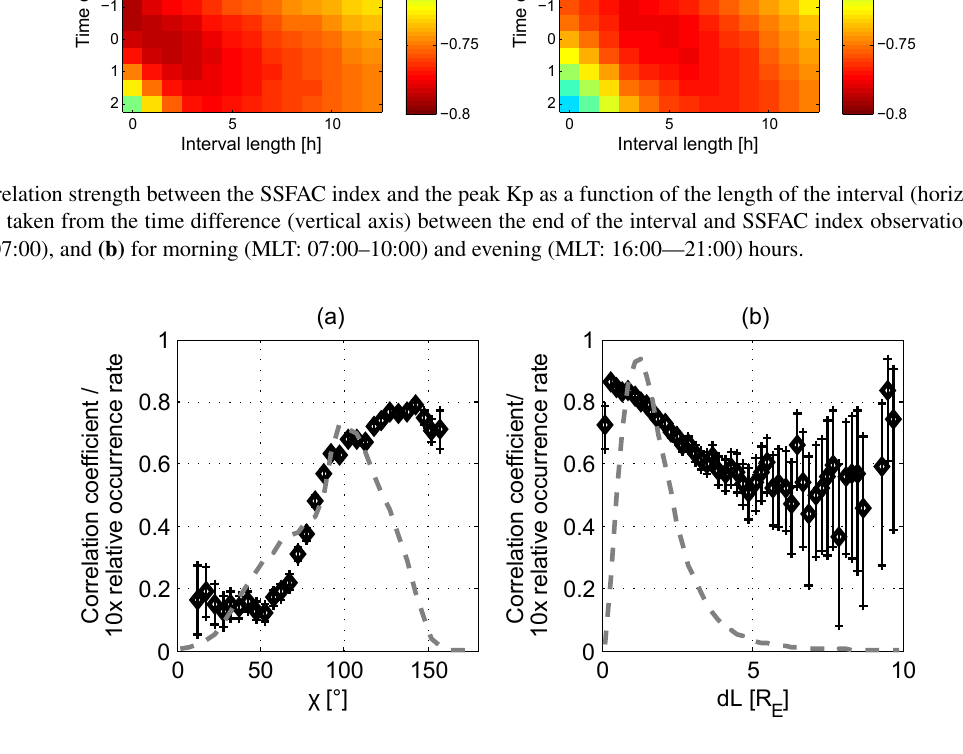
Figure 3. (a) Dependence of the L ssfac –Kp correlation on the solar zenith angle “ χ ” while “ dL ”<3 (diamonds) with 95% confidence intervals (vertical lines) along with 10 times the relative occurrence rate of “ χ ” values (dashed line), and (b) the same correlation/occurrence rates in the same format as in (a) but as a function of the boundary width “ dL ” while χ >90 ◦